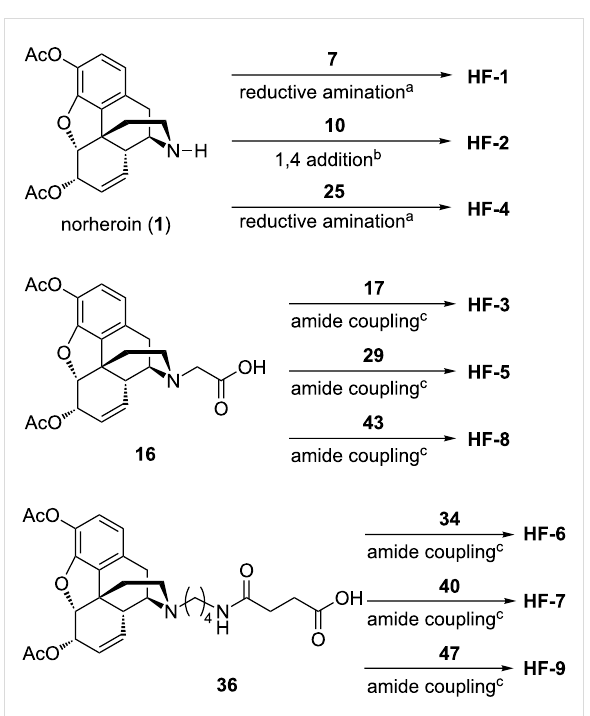
Scheme 5: General strategy and coupling partners for the chemically contiguous series. a General conditions for reductive amination of 1 with indicated aldehyde: NaBH(OAc) 3 (2.5 equiv), AcOH, 0 °C → rt. b Conditions for 1,4-addition of 1 to 10 : Zn(OTf) 2 (0.2 equiv), CH 3 CN,